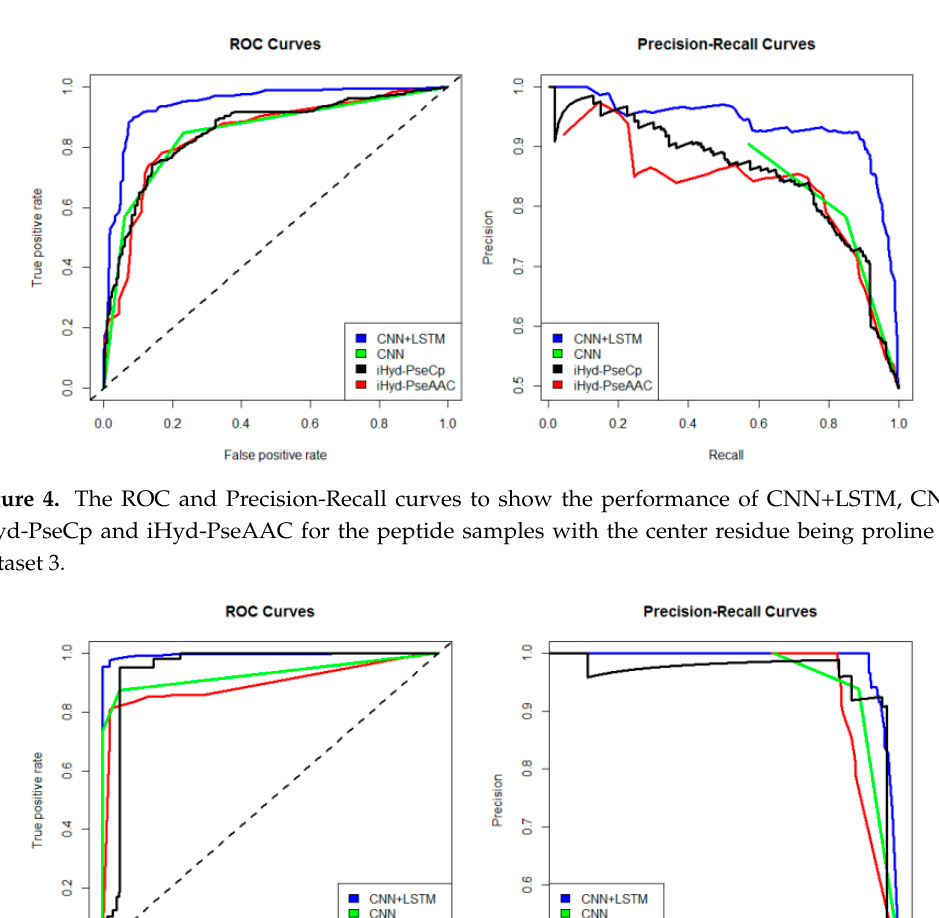
Figure 3. The ROC and Precision-Recall curves to show the performance of CNN+LSTM, CNN, iHyd-PseCp and iHyd-PseAAC for the peptide samples with the center residue being proline on Dataset 2.